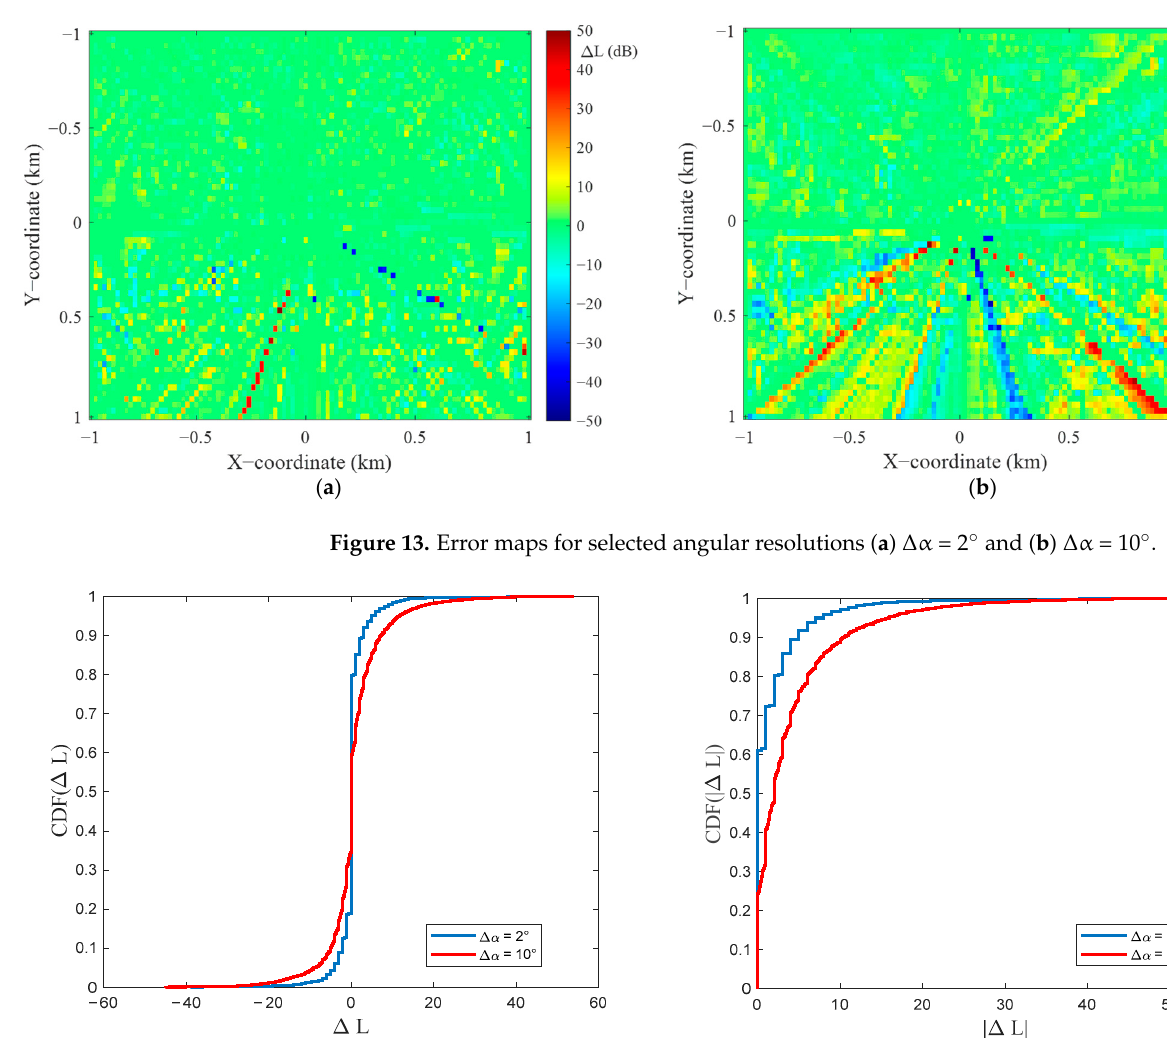
Figure 14. CDFs of ( a ) attenuation error and ( b ) attenuation error module for selected angular resolution of terrain profiles.